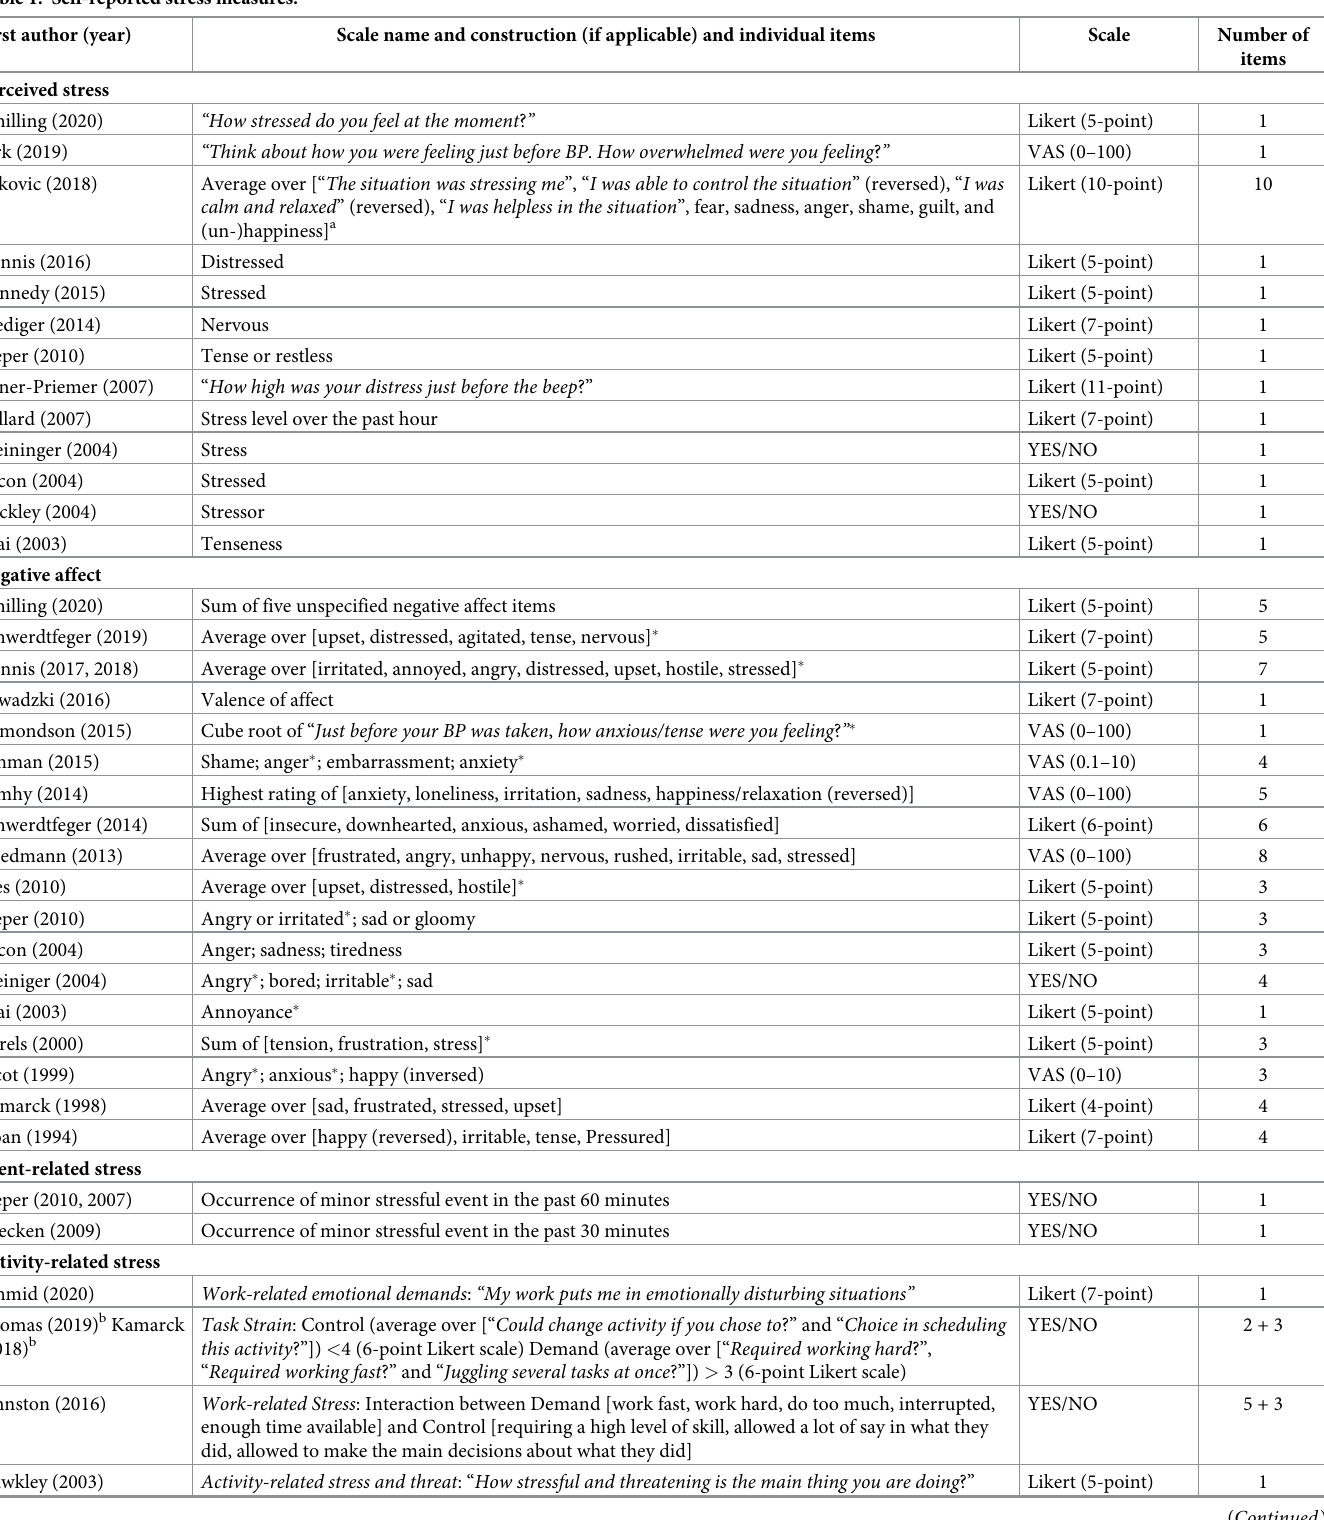
Table 1. Self-reported stress